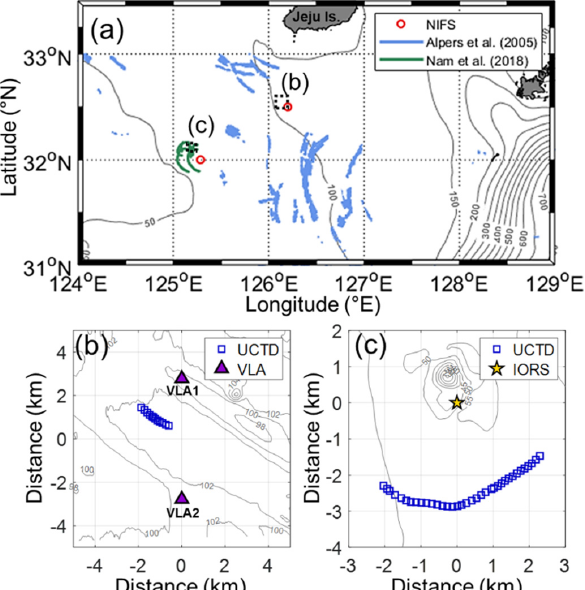
Figure 1. ( a ) Map showing the geographic region of this study for two areas of experiments (black dashed boxes), bathymetry (grey lines), and distribution of surface manifestation of NLIWs described by Alpers et al. [35] (blue lines) and Nam et al. [36] (green lines). Two stations conducting historical hydrographic data sampling for the National Institute of Fisheries Science (NIFS) used in this study are marked by red open circles. Zoomed-in maps of the two areas of ( b ) Shallow-water Acoustic Variability EXperiment 2015 (SAVEX15) and ( c ) Ieodo Ocean Research Station 2018 (IORS18). Locations of underway conductivity–temperature–depth (UCTD) data collection, moored observations (VLA1 and VLA2), and Ieodo Ocean Research Station (IORS) are marked by blue open squares in ( b , c ), purple triangles in ( b ), and yellow stars in ( c